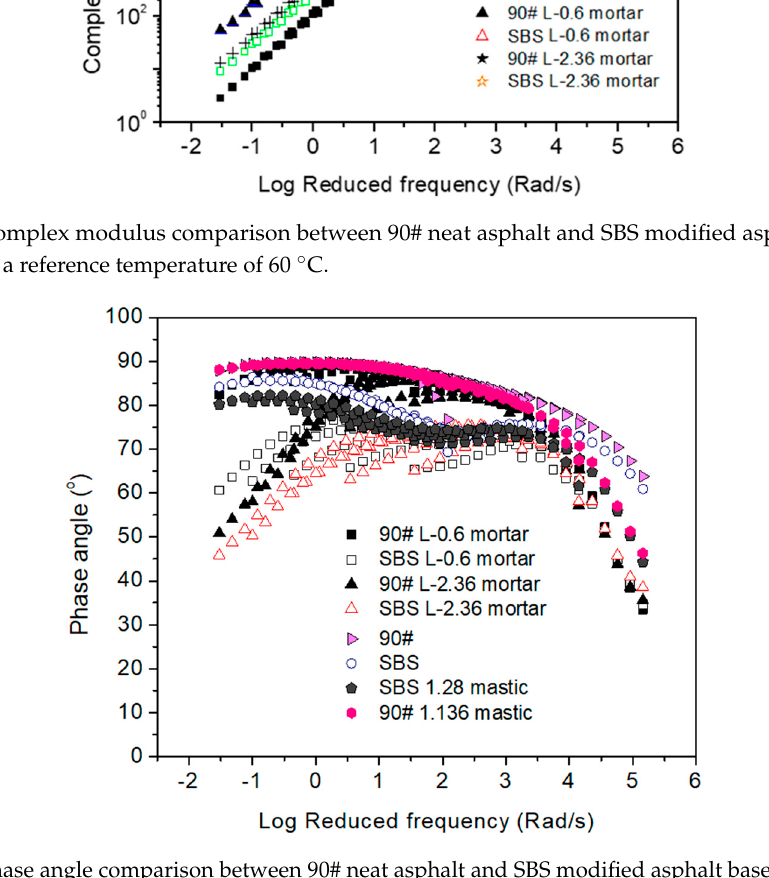
Figure 8. Phase angle comparison between 90# neat asphalt and SBS modified asphalt based materials at a reference temperature of 60 °C.